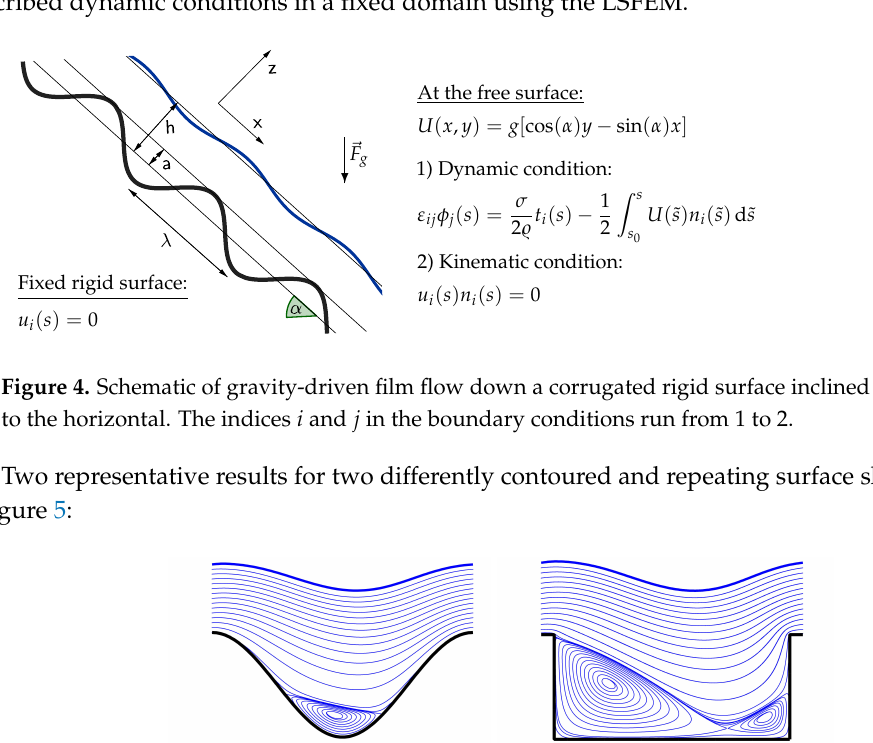
20.1 mN/m, λ = 20 mm, A = 4 mm, H 0 = 5 mm, α = 10 ◦